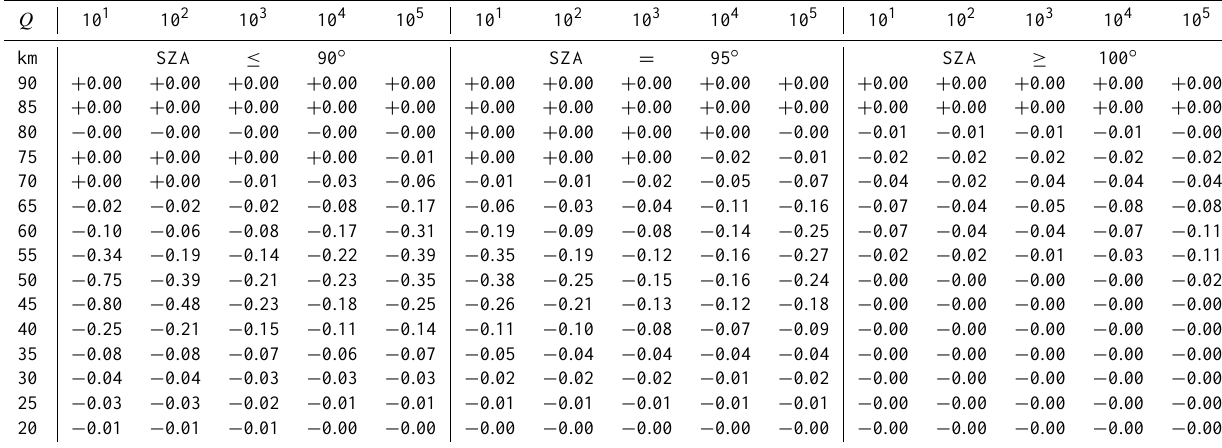
Table A29. P NO /Q for October SH.